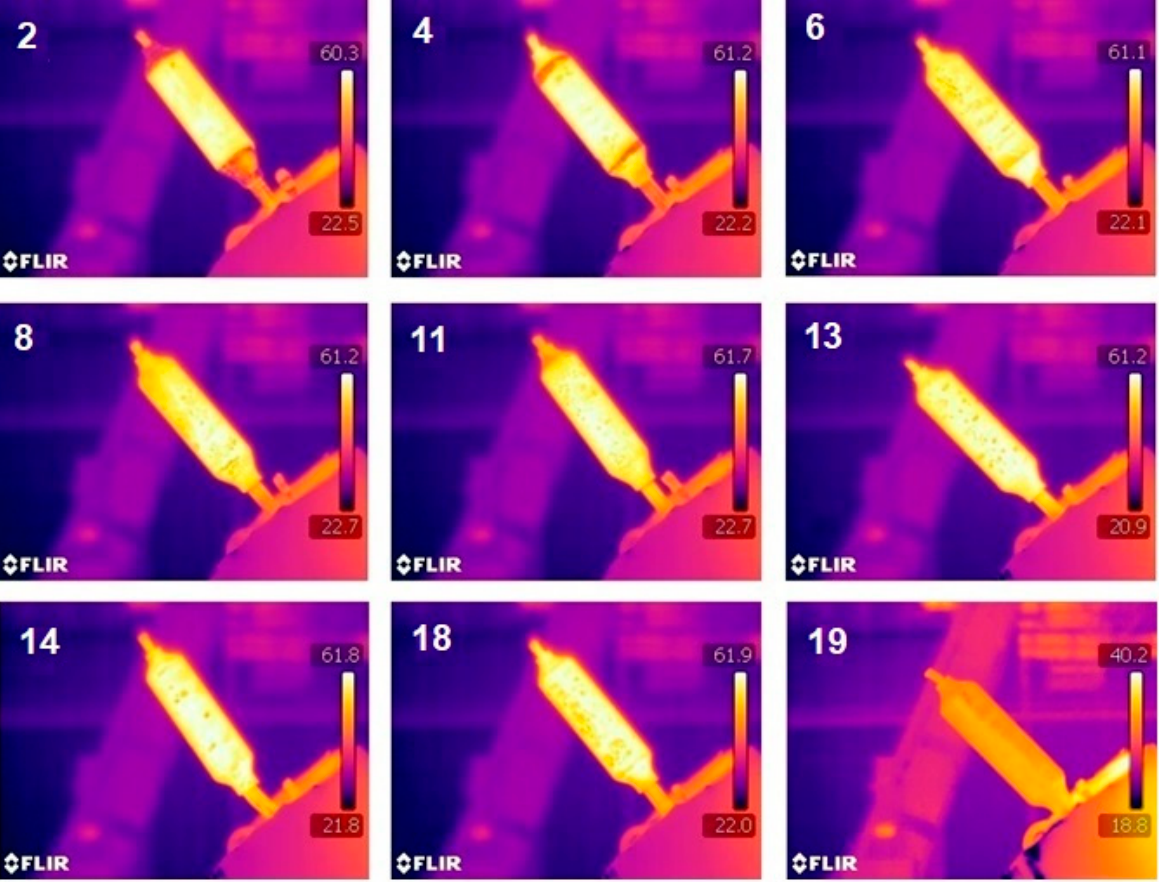
Figure 15. Thermograms taken during the research. For each test sample, the tank’s water temperature and the condenser’s surface tem- perature were measured after a steady state had been obtained. The temperature